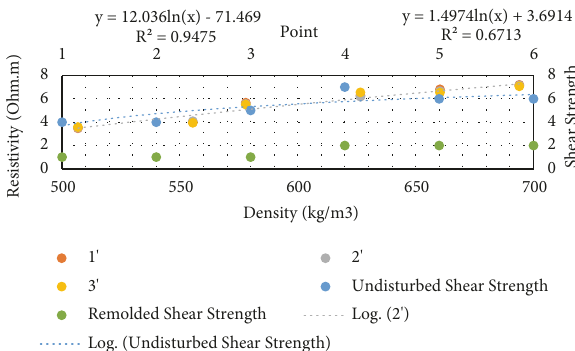
Figure 4: Soil Resistivity and soil shear strength vs soil salinity. y = 4.1963ln(x) -25.062 R² = 0.1205